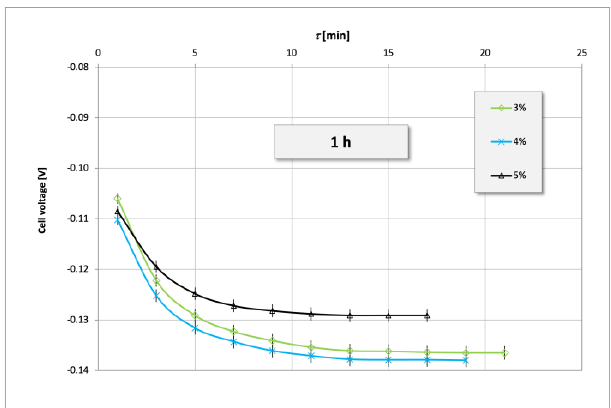
Figure 2. Cu-Ag cathode oxidized for 1 h — the electroless potential of cathode.